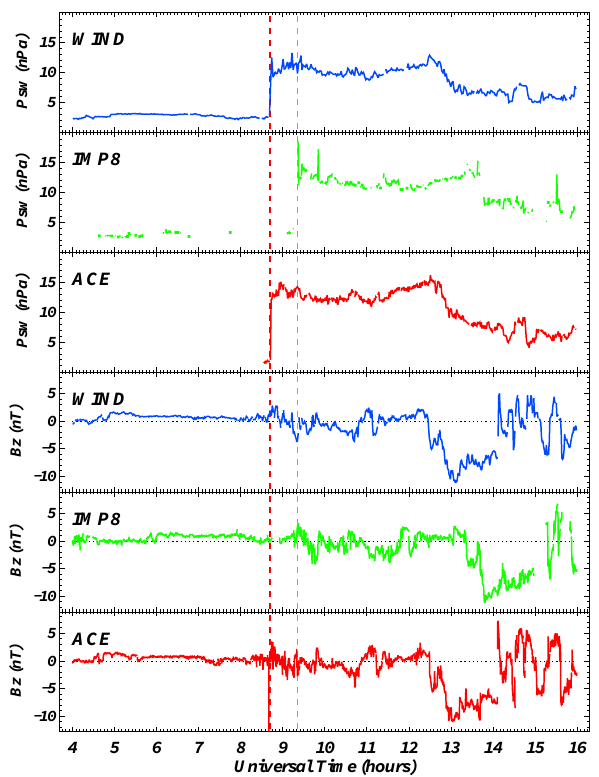
Fig. 5. Solar wind conditions for 30 April 1998. The top three panels show the solar wind dynamic pressure observed by WIND, IMP8, and ACE, while the three bottom panels show the IMF B z component in GSE coordinates measured by the same space- craft. WIND, IMP8, and ACE were located at X GSE ∼ 217 R E , X GSE ∼ 27 R E , and X GSE ∼ 229 R E , respectively. The vertical lines mark the detection times of the front by the three spacecraft. The high pressure front impacted the magnetosphere at ∼ 09:25